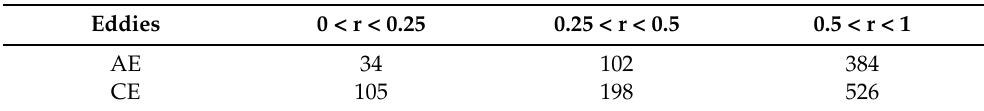
Table 1. Number of profiles collected inside the eddies in regard to different classes of their normal- ized